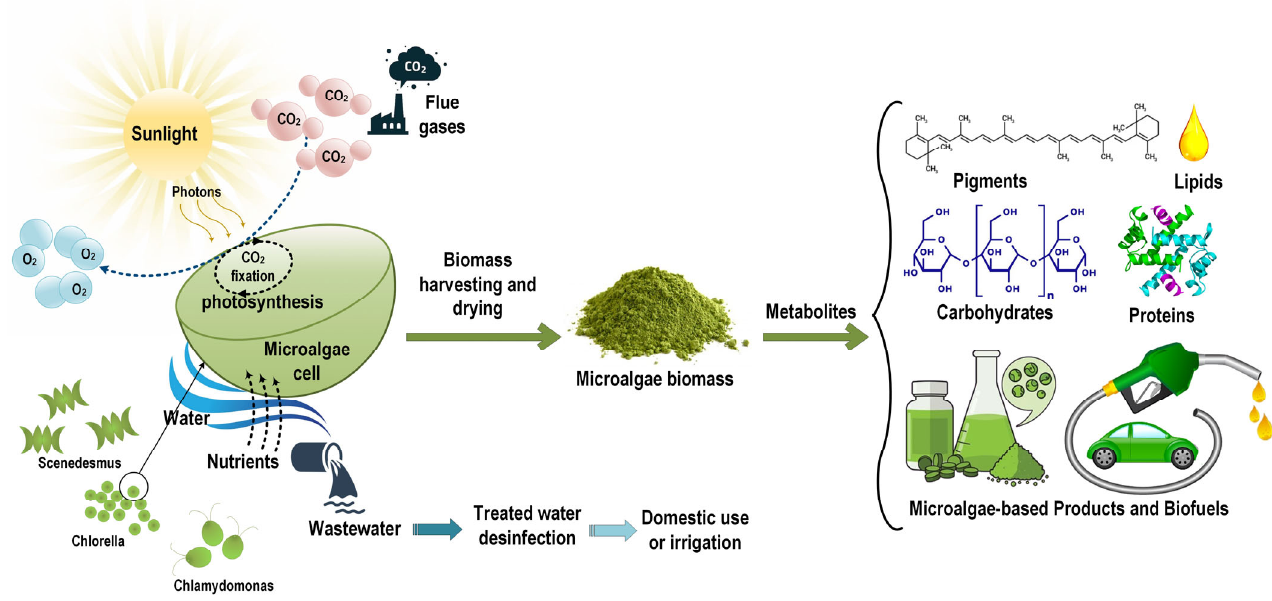
Figure 5. Microalgae as CO 2 biofixers, O 2 producers, and potential applications of microalgae biomass (adapted with permission from Mata et al. [7]).